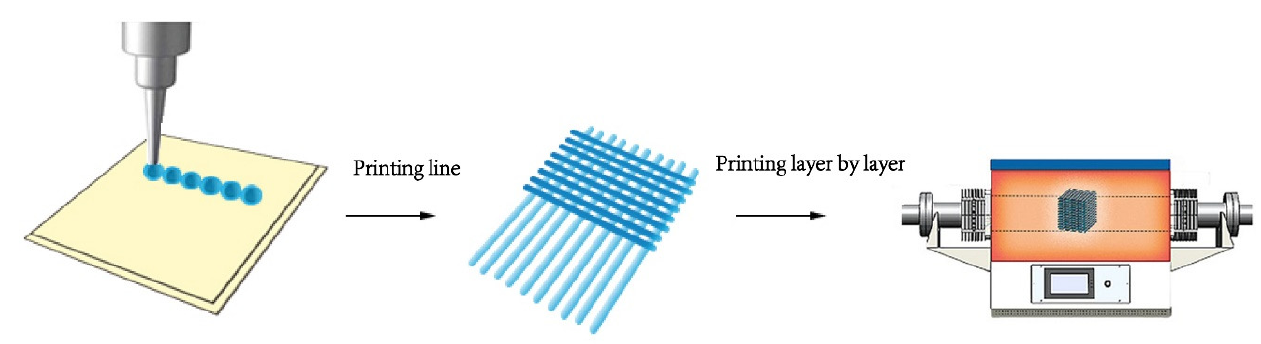
Figure 12. Schematic diagram of 3D printing process [94].